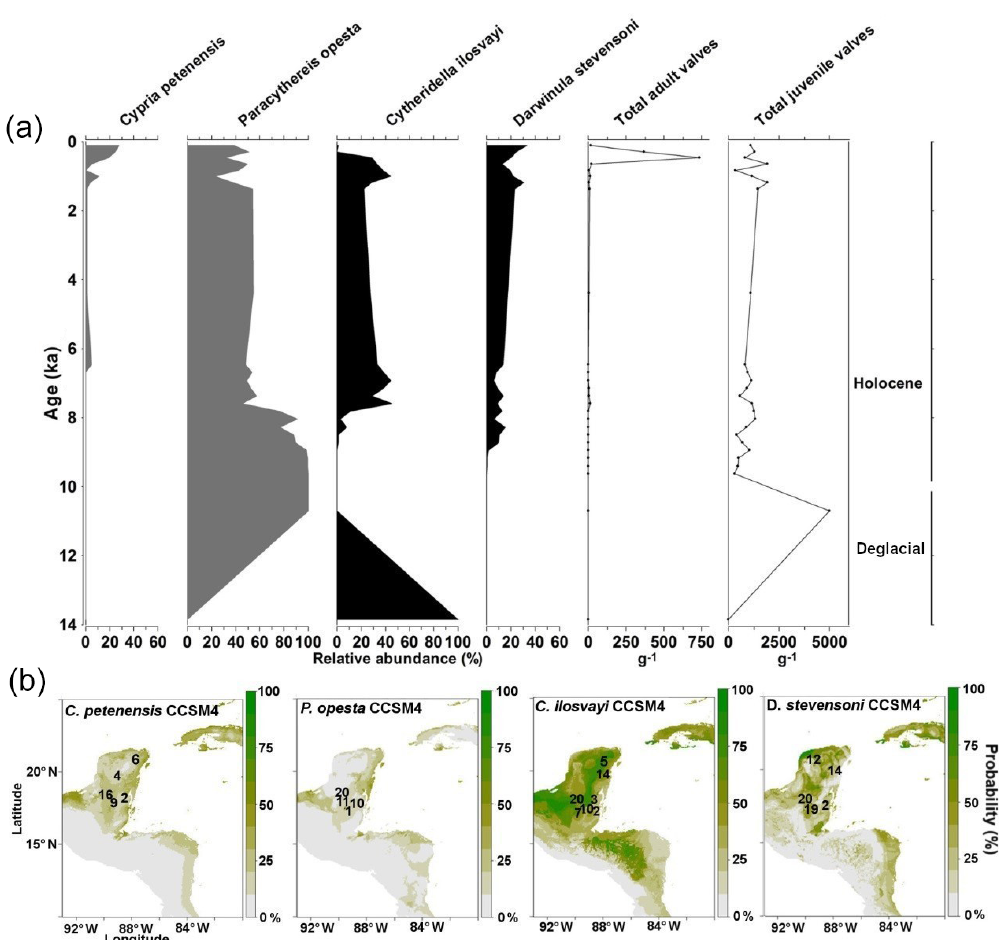
Figure 5. Fossil record of the last 14kyr and species niche modelling results for the ∼ 6ka (representing middle Holocene climate) for four ostracode species: Cypria petenensis , Paracythereis opesta , Cytheridella ilosvayi and Darwinula stevensoni . (a) Ostracode fossil record from core Petén Itzá 22-VIII-99. (b) Map showing the probability of suitable species distribution based on the CCSM4 climate model. Numbers in maps represent regional fossil records. Numbers correspond to those in the Supplement (Table